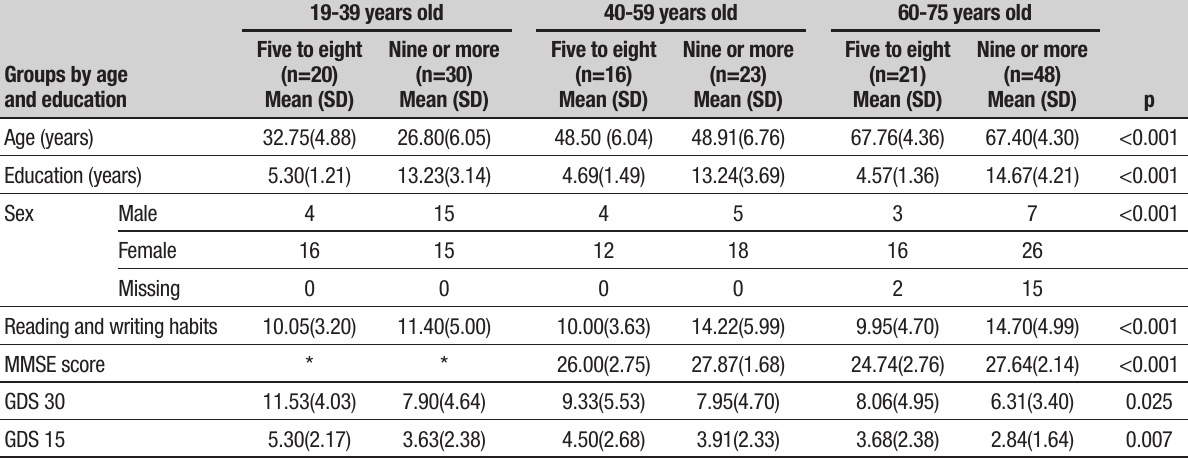
Table 3. Sociodemographic, cultural and clinical characteristics of preliminary normative groups for Stroop color and word test.